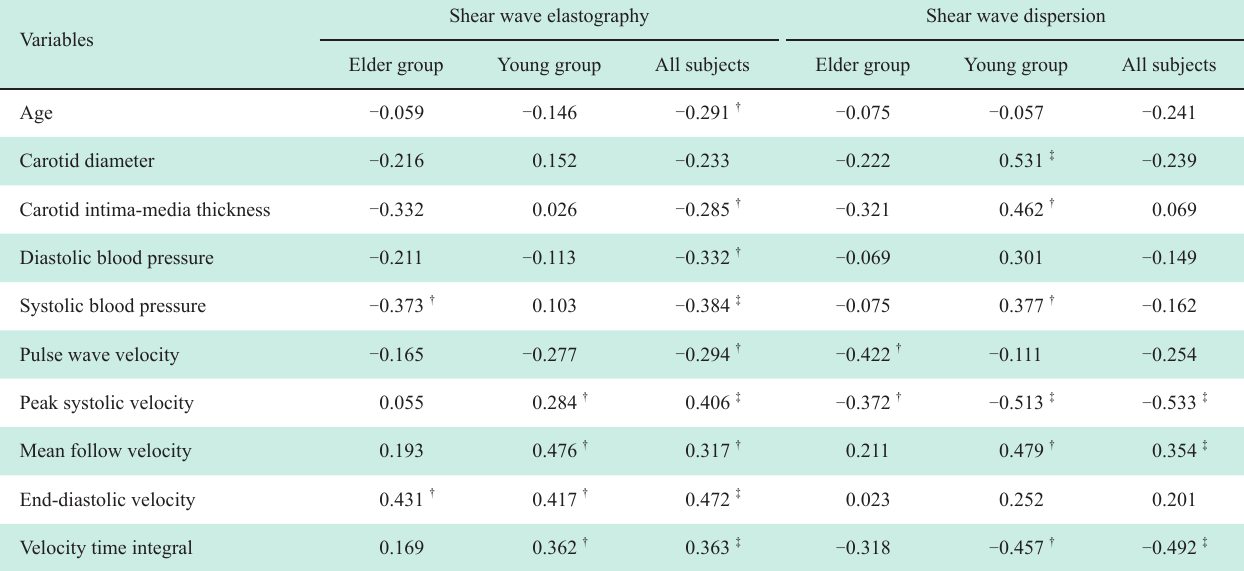
Table 3 Correlation analysis of shear wave elasticity and viscosity parameters versus CCD risk factors